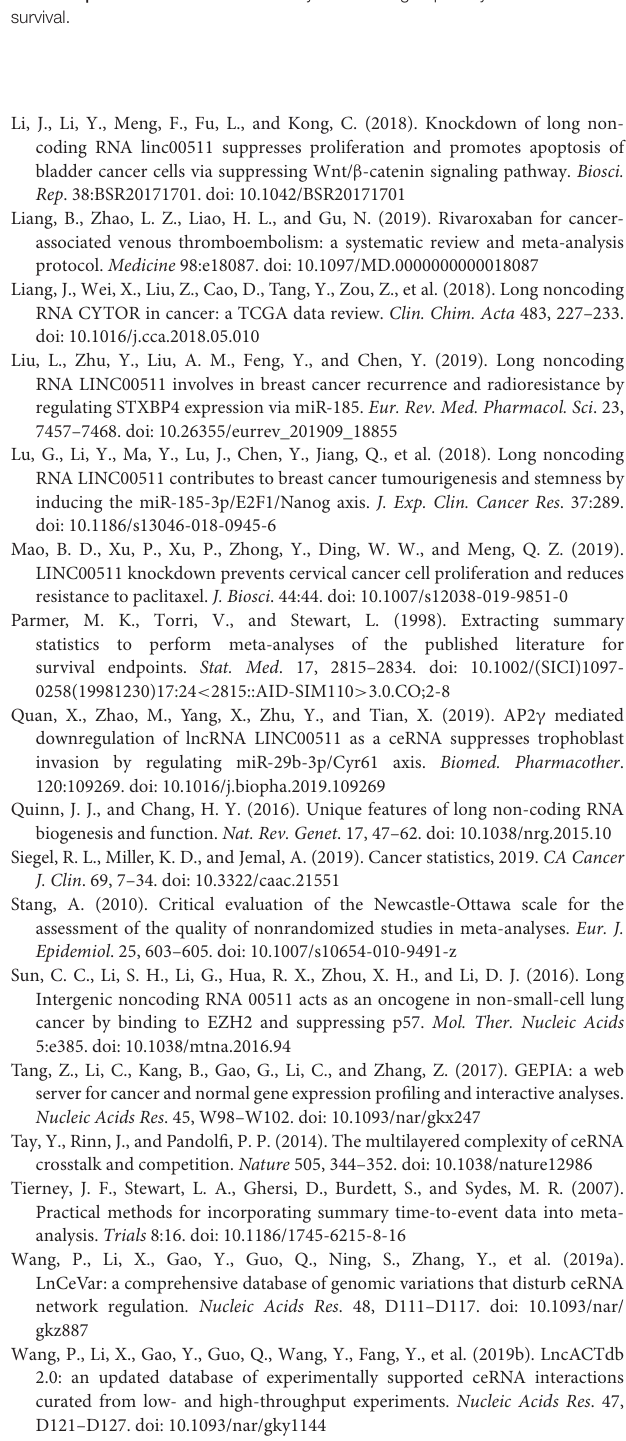
Figure S1 | Forest plots of hazard ratios for the association between LINC00511 expression and overall survival after excluding the study by Sun et al. (2016).